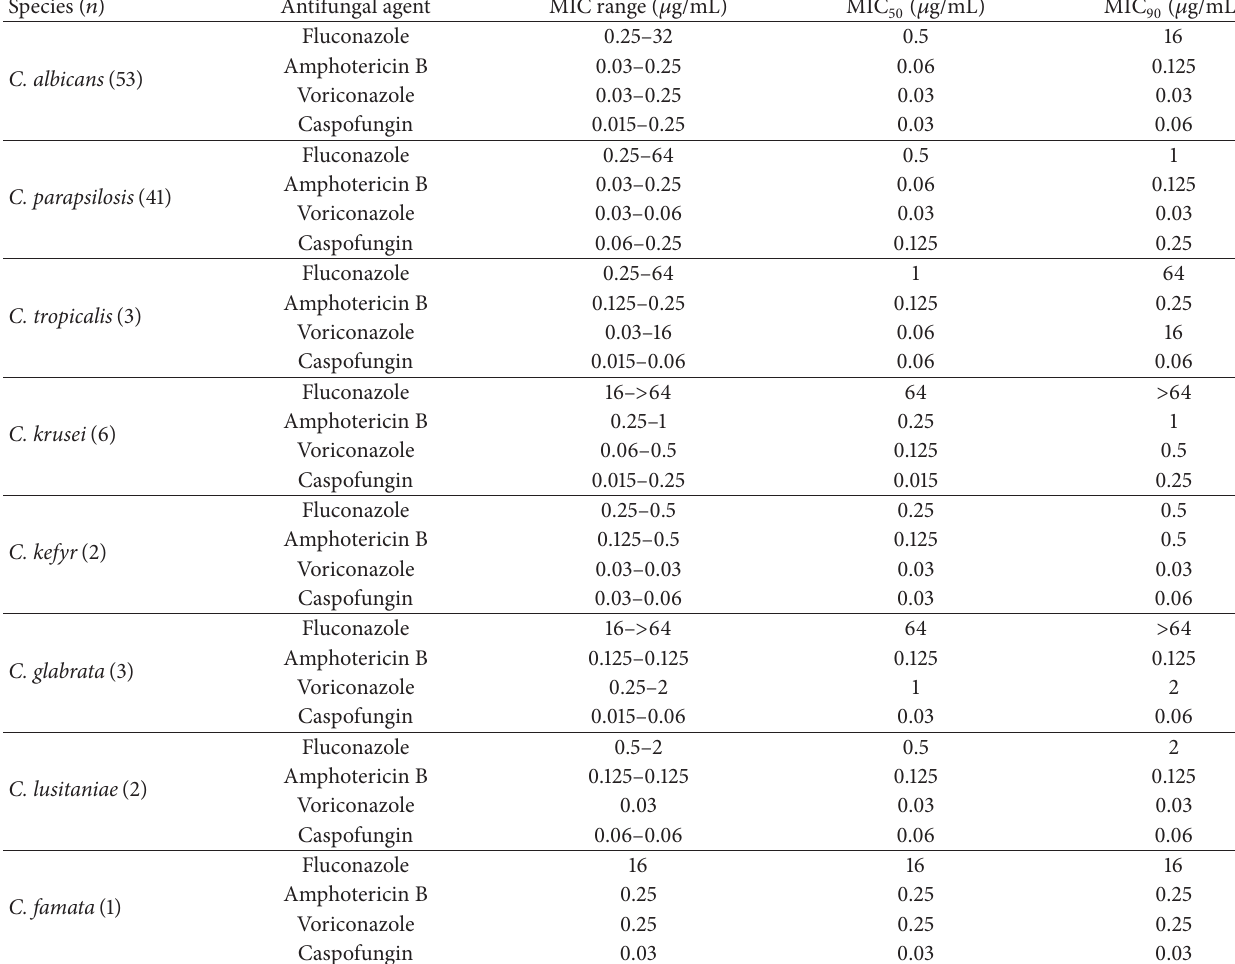
Table 2: MIC ranges as well as MIC Species ( 𝑛